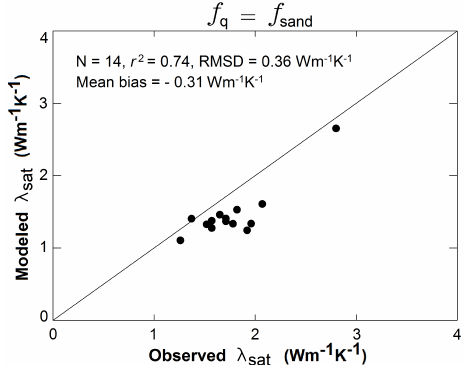
Figure 5. λ satMOD values derived from volumetric quartz fractions f q assumed equal to f sand , using observed θ sat values, vs. λ sat re-